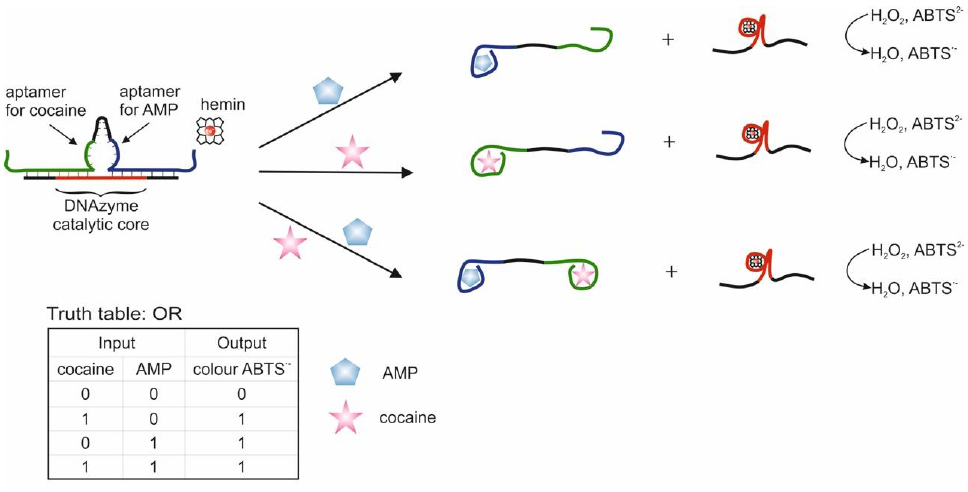
Figure 3. Logic gate OR [65]. AMP = adenosine 5′-monophosphate; ABTS =